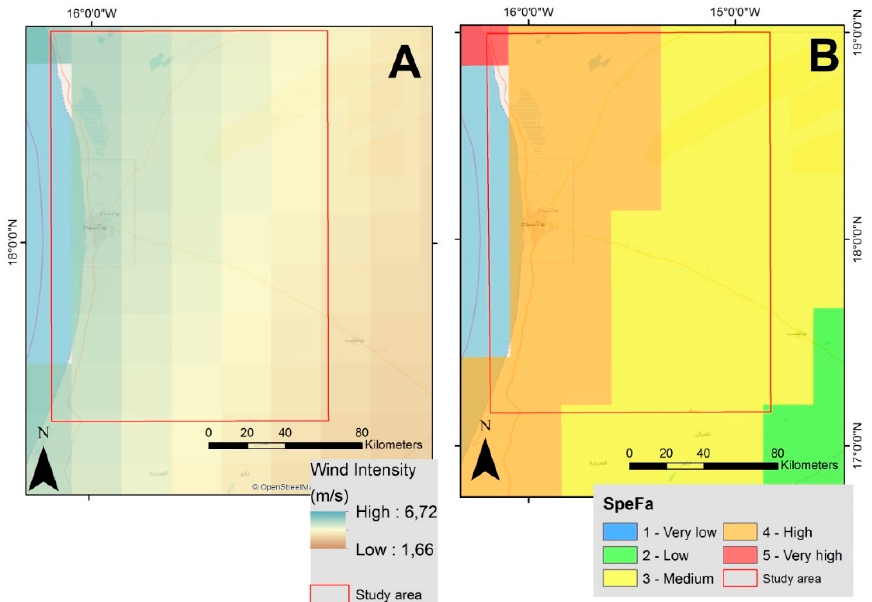
Figure 2. ( A ) Wind intensity map and ( B ) Speed Factor (SpeFa) vulnerability map.